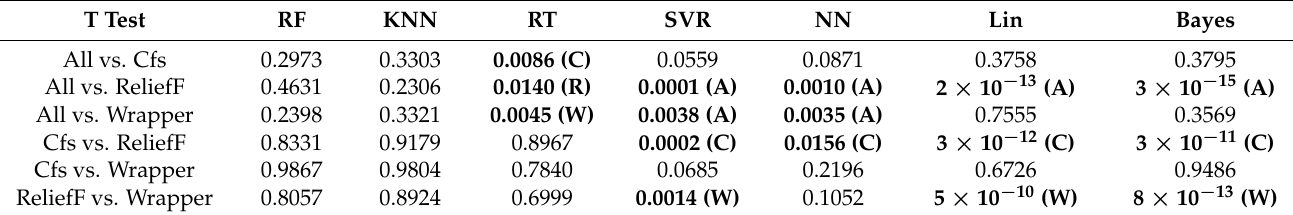
Table 9. p -values between R 2 values of different feature selection operators. Results from unpaired two-tail t tests. ‘All’ represents the results from Table 3, ‘Cfs’ represents the results which used the features from Figure 5/Table 5, ‘ReliefF’ represents the results from Figure 6/Table 7, and ‘Wrapper’ represents the results from Figure 7/Table 8. If a p -value is followed by a parenthesis, the value in the parentheses is an abbreviation of the feature selection method that resulted in the higher average R 2 value. Lower p -values are better, and the lowest are bolded.